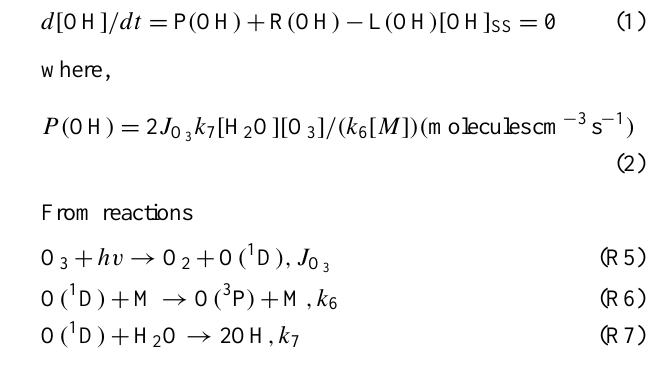
Fig. 1. Steady-state calculation scheme used in this